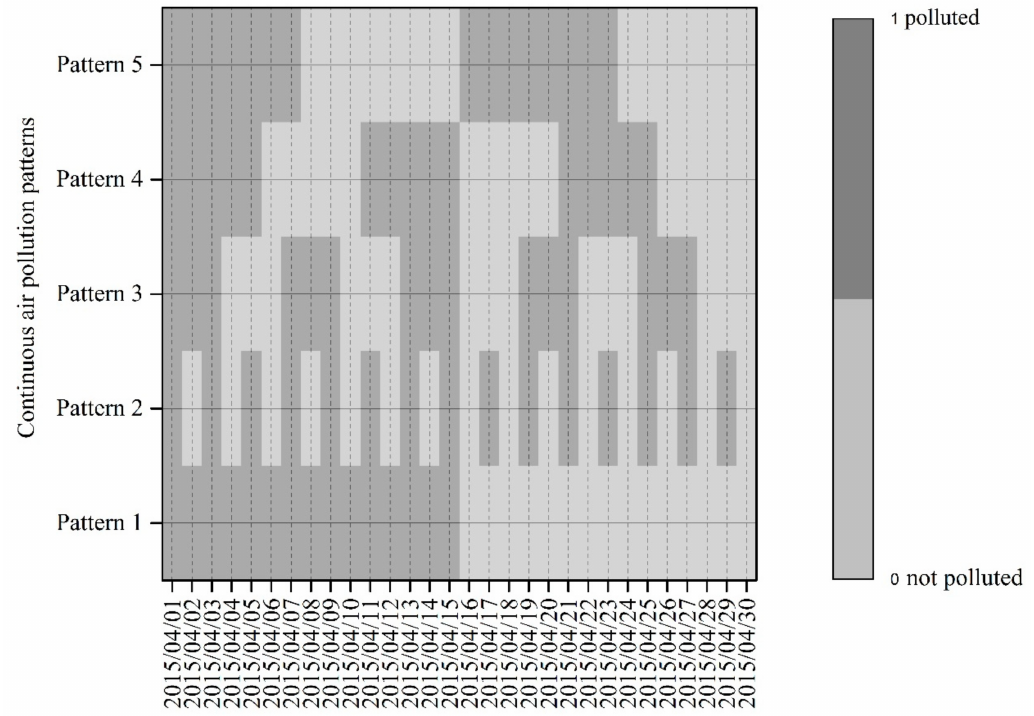
Figure 1. Hypothetical scenarios of continuous air pollution patterns in five cities. The figure assumes that the temporal distributions of daily air quality index in April 2015 for five Chinese cities have different continuous air pollution